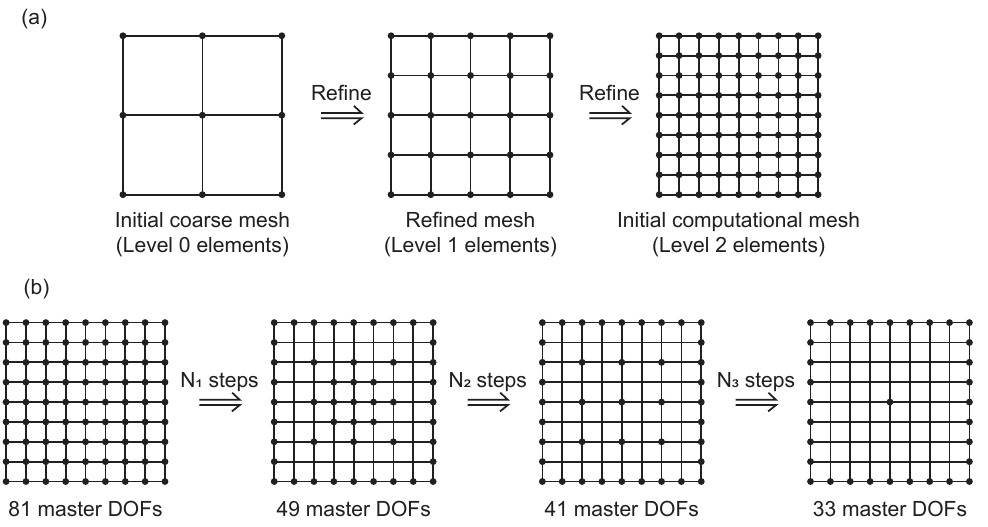
Figure 1. Illustration of adaptive DOFs condensation: ( a ) Form the initial computational mesh. ( b ) Condense the DOFs with the computation time